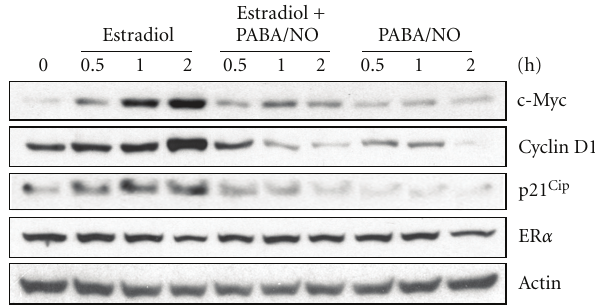
Figure 6: PABA/NO compromises ER α -mediated gene expression. MCF7 cells were treated with DMSO, 20nM β -estradiol (E2), 20 μ M PABA/NO or both for the indicated times. Cell lysates (40 μ g) were subjected to Western blot with the indicated